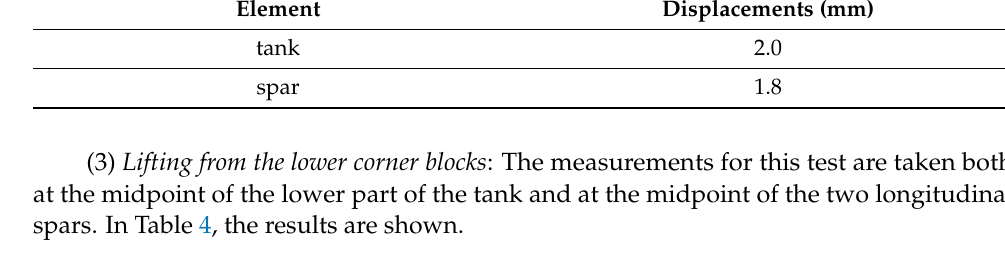
Table 4. Displacements detected during the lifting from the lower corner